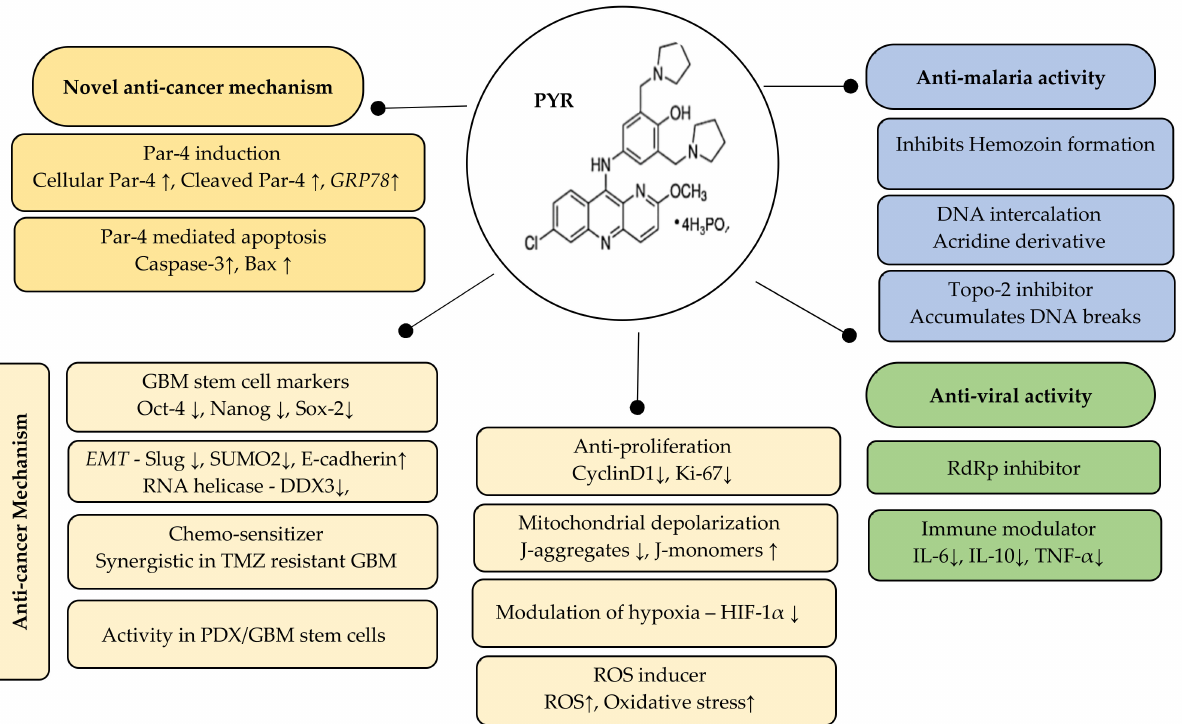
Figure S1: PYR induced cell cycle changes in GBM cell lines after 24, 48 and 72 h; Figure S2: PYR cells; Figure S4: Primer sequences; Figure S5: qPCR conditions; Figure S6: Modulation of stem cell, hypoxia, proliferation and EMT genes markers in GBM Cells; Figure S7: Online BBB predictor for PYR, TMZ and Penicillin. Supplementary S2: Western blot raw data. Supplementary S3: Raw data for gene expression